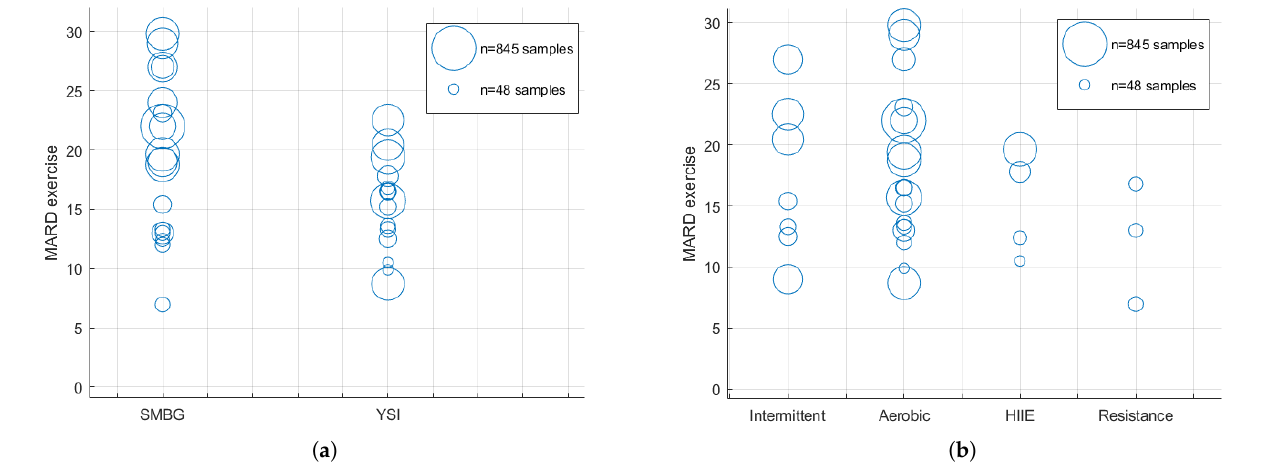
Figure 1. Panel ( a ) shows the MARD for the exercise periods according to the reference used. The SMBG column displays data from studies where self-monitoring blood glucose samples were used to calculate the CGM accuracy. The YSI column stands for those studies that used gold-standard reference methods (YSI or equivalent) to calculate the CGM accuracy. Panel ( b ) displays MARD data for the exercise periods grouped according to the type of exercise. The radius of each bubble is proportional to the number of samples used for the computation of MARD values.